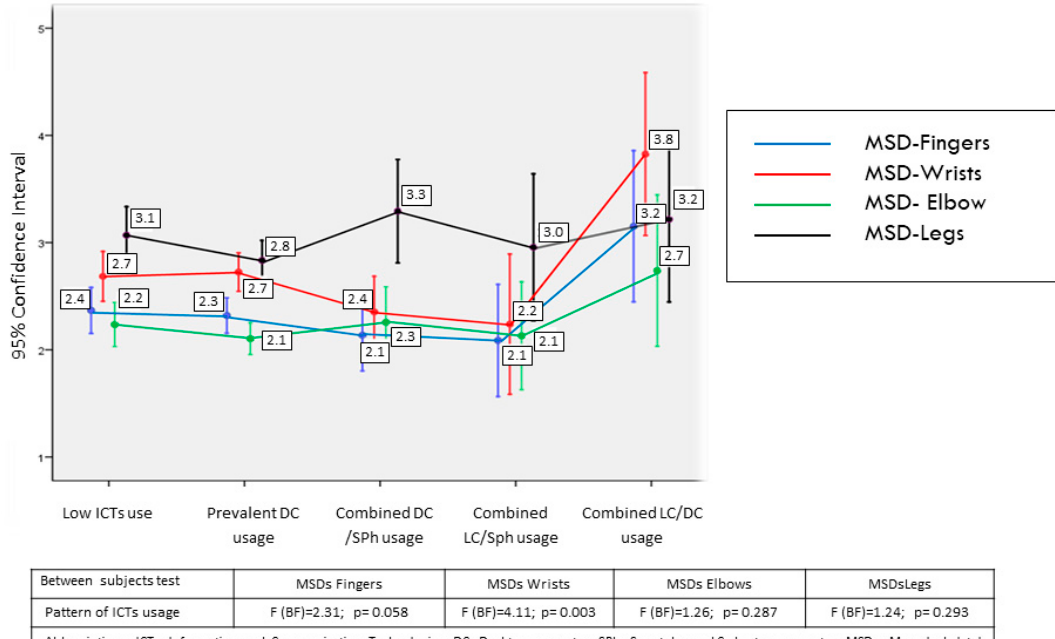
Figure 3. Relationships between MSDs and ICT usage pattern